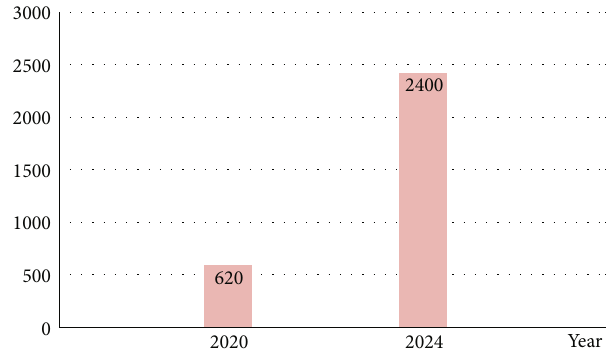
Figure 2: Market scale of global virtual reality industry in the future (unit: 100 million